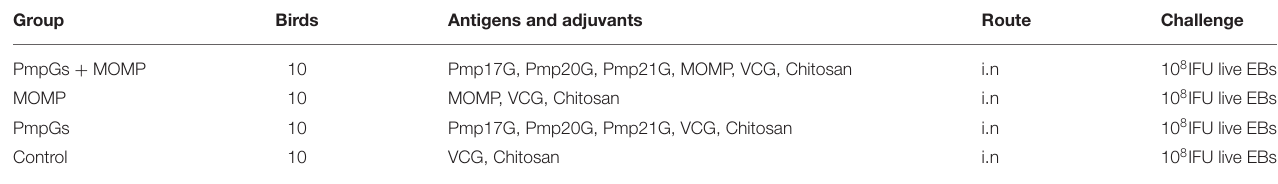
TABLE 1 | Inoculations and challenge of SPF chickens. Group Birds Antigens and adjuvants